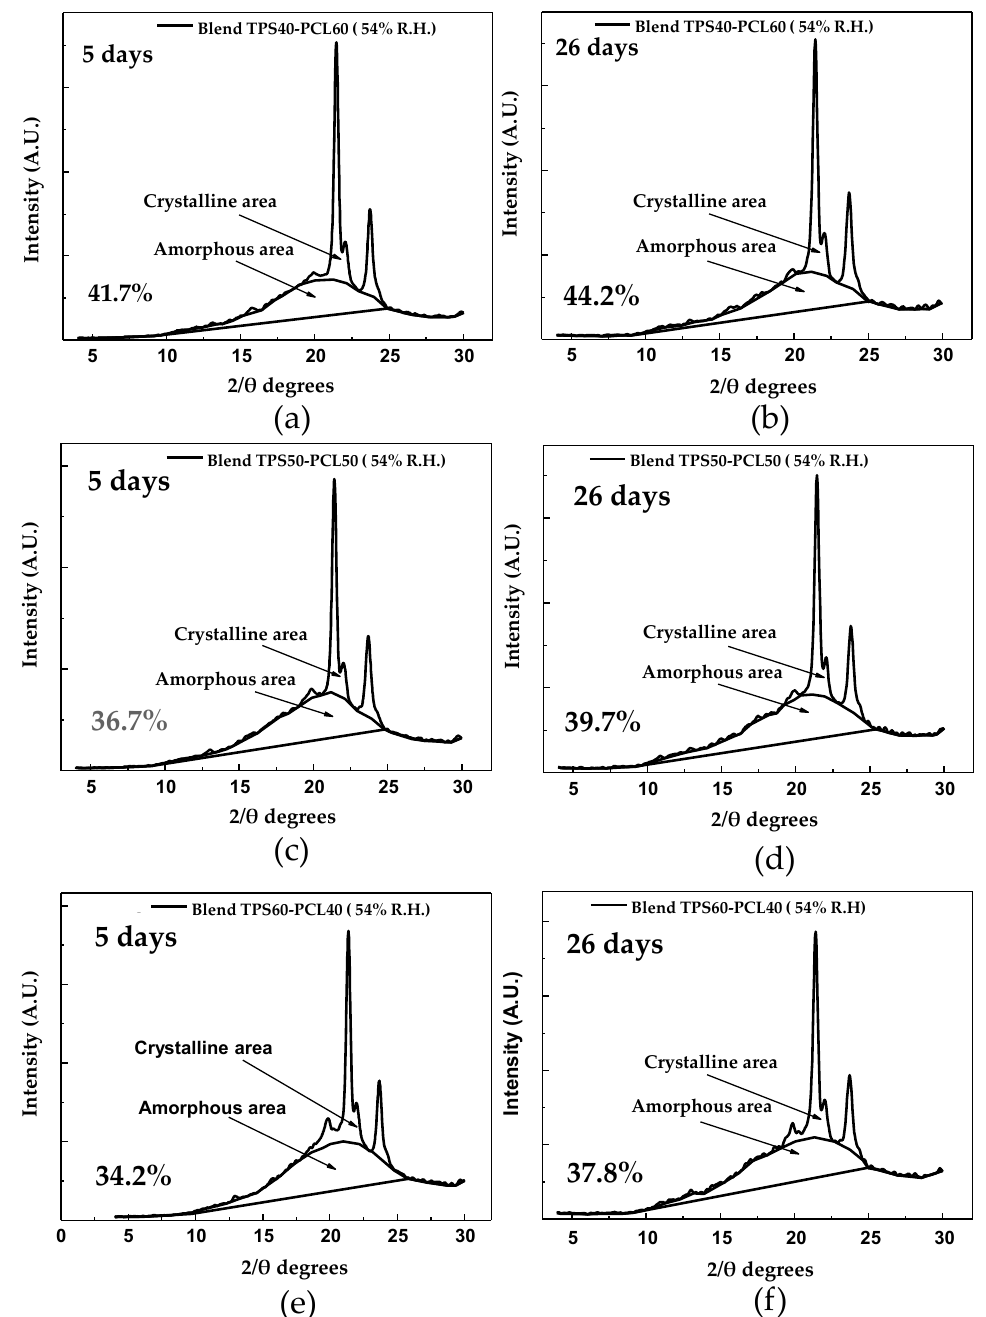
Figure 8. Crystalline and amorphous areas of: ( a ) TPS/PCL 40/60 binary blend conditioned at 5 days; ( b ) TPS/PCL 40/60 binary blend conditioned at 26 days; ( c ) TPS/PCL 50/50 binary blend conditioned at 5 days; ( d ) TPS/PCL 50/50 binary blend conditioned at 26 days; ( e ) TPS/PCL 60/40 binary blend conditioned at 5 days; ( f ) TPS/PCL 60/40 binary blend conditioned at 26 days.